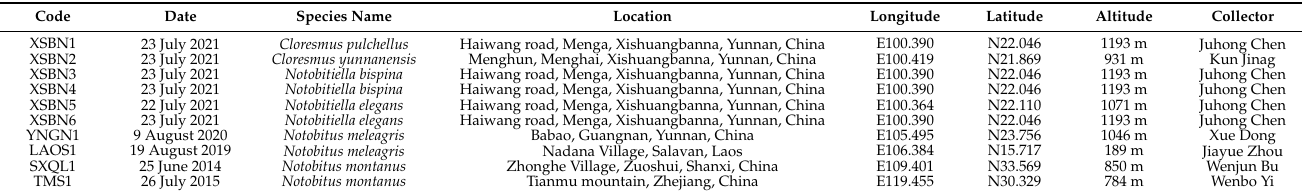
Table 1. Collected information of specimens used for molecular